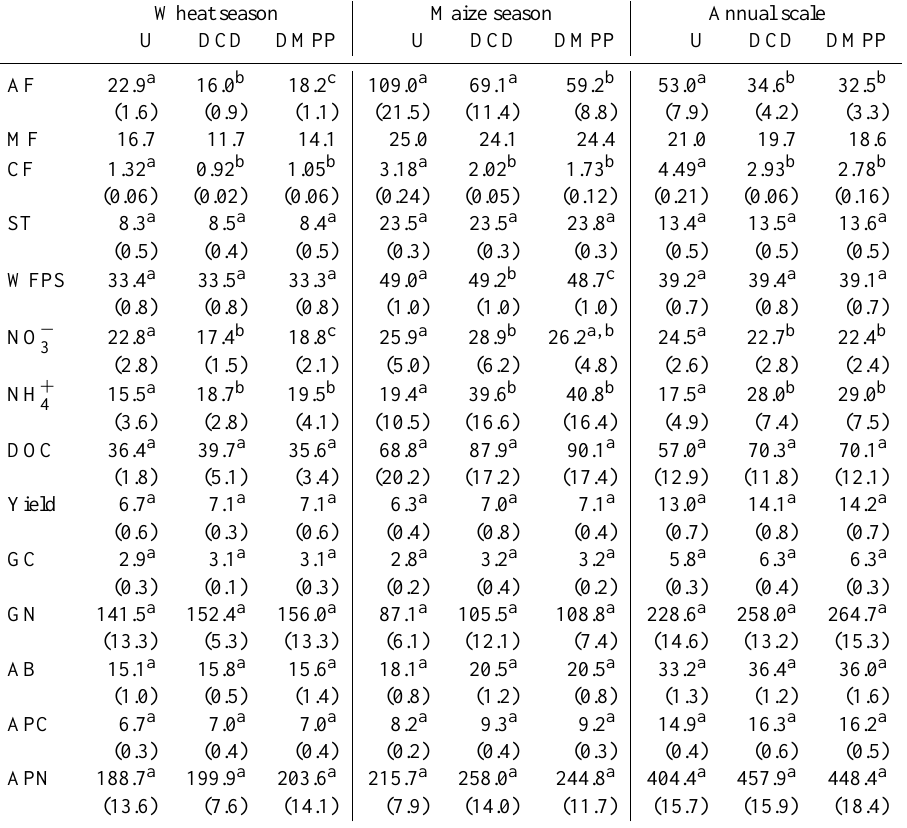
, mgNkg − 1 SDW), ammonium (NH + , mgNkg − 1 SDW) and 3 4